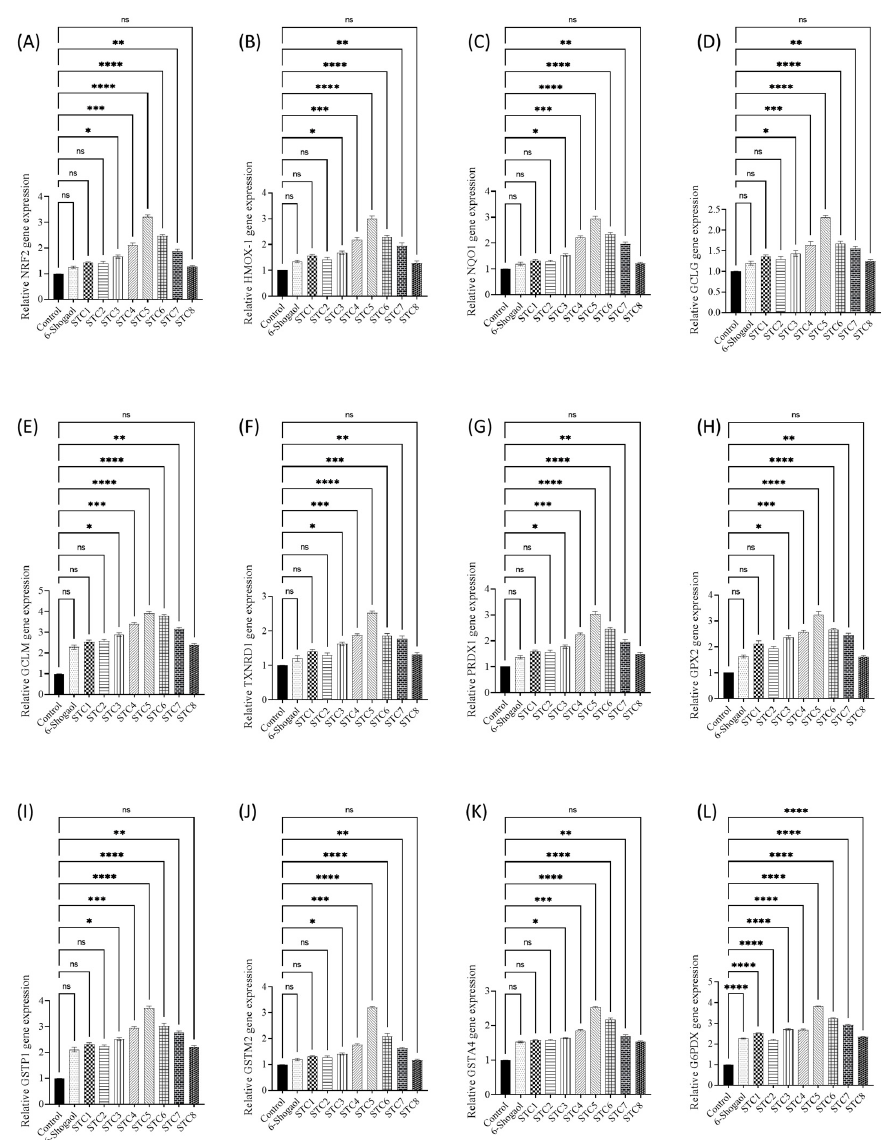
Figure 4. The effect of STCs and 6-shogaol on the expression of representative antioxidant genes ( A ) nuclear factor erythroid 2–related factor 2 (NRF2), ( B ) heme oxygenase-1 (HMOX1), ( C ) human NADPH quinone oxidoreductase (NQO1), ( D ) GCLG, ( E ) glutamate-cysteine ligase modifier subunit (GCLM), ( F ) thioredoxin reductase 1 (TXNRD1), ( G ) Peroxiredoxin-1 (PRDX1), ( H ) glutathione peroxidase 2 (GPX2), ( I ) glutathione S-transferases P1 (GSTP1), ( J ) glutathione S-transferase Mu 2 (GSTM2), ( K ) g lutathione S-transferase alpha 4 (GSTA4), ( L ) glucose-6-phosphate dehydrogenase X-linked (G6PDX) in Hepa-1c1c7 cells. The expressions of these genes were found to be significantly upregulated by the compound STC5. The experiment was performed in triplicate and each experiment was repeated twice. ns , not significant; p < 0.05 (*); p < 0.01 (**); p < 0.001 (***); and p < 0.0001